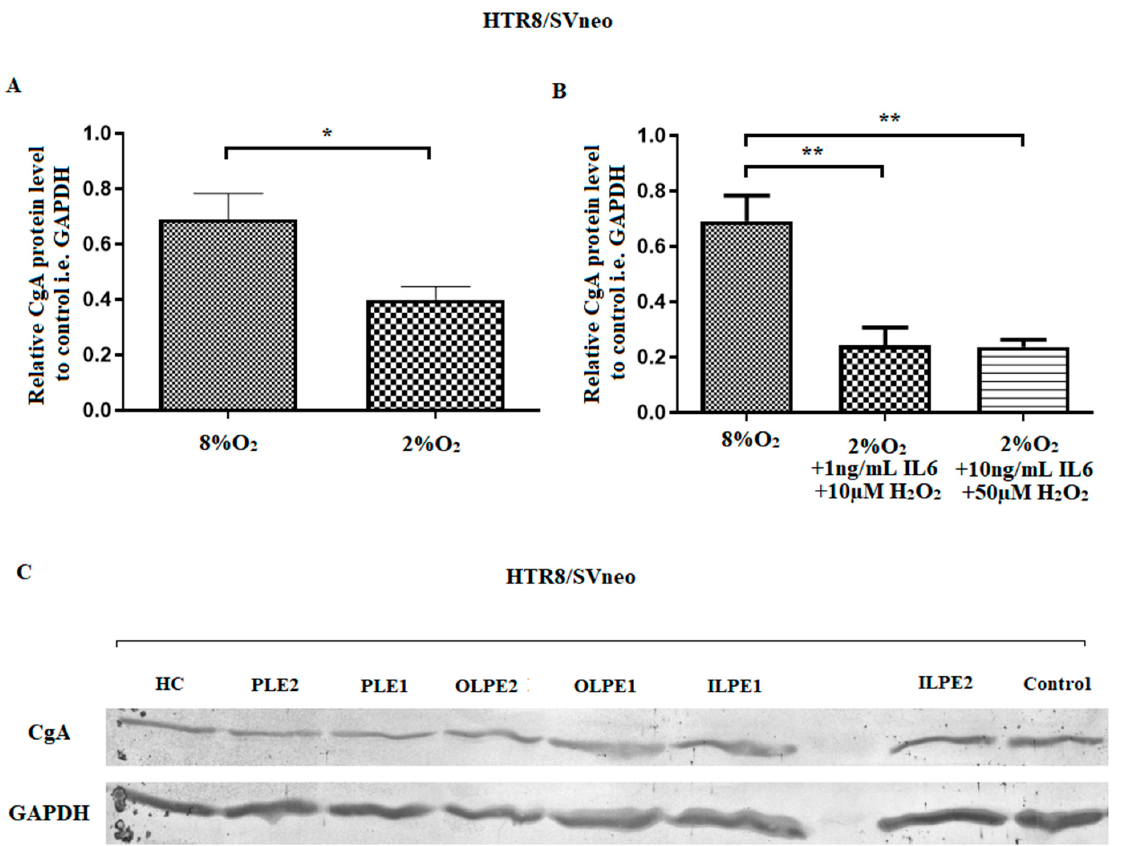
Figure 2. Relative CgA protein level compared to GAPDH level (housekeeping gene) in HTR-8/SVneo cells under different stimulation regimens, as indicated by Western blot analysis. ( A ) All cells were cultured in medium with 2.5%FBS in normoxic (control) or hypoxic conditions. The 8%O 2 (control) and 2%O 2 cultures were compared using the Student’s t -test. ( B ) CgA expression in cells incubated in medium including IL6 and H 2 O 2 under hypoxia (preeclamptic) conditions were compared with untreated controls using one-way ANOVA with Bonferroni’s correction. The results are expressed as mean ± SEM ( n = 3). The level of significance was assumed as p < 0.05; ** p < 0.01, * p < 0.05 compared to control. ( C ) The representative results of Western blot analysis showing bands for CgA and the control GAPDH protein; C—Control (8%O 2 ), HC—Hypoxic conditions (2%O 2 ),